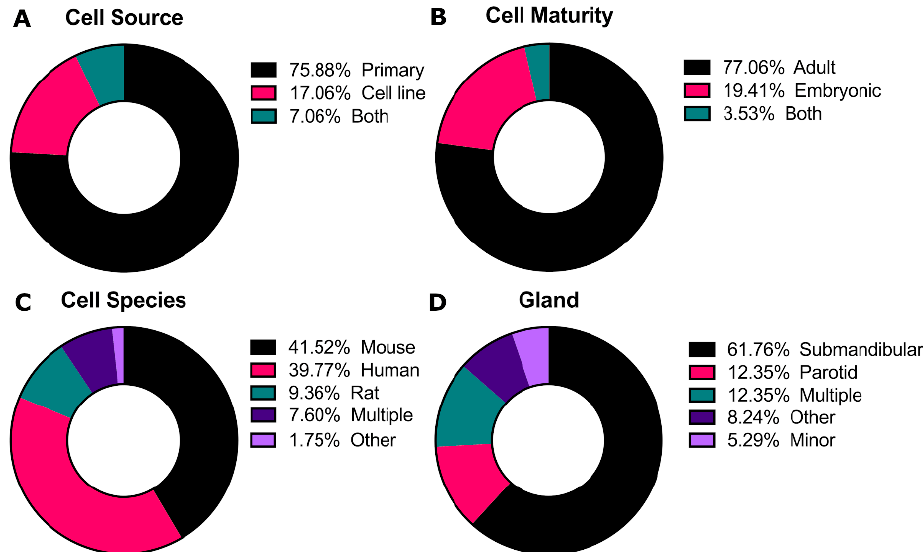
Figure 3. Categorization of the cells used in salivary gland culture in vitro. Distribution of the percentage frequency of the ( A ) cell source, (B) cell maturity, ( C ) cell species, and ( D ) gland type in the articles analyzed in this review.